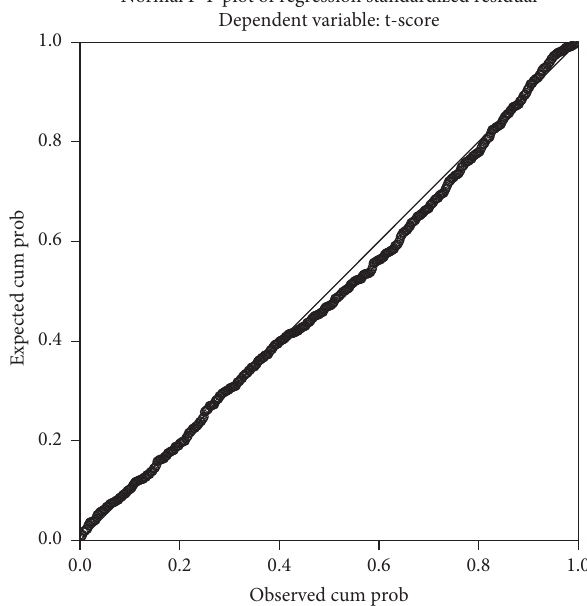
Figure 2: Normal probability plot of regression standardized re- sidual for academic burnout mode. Table 3: Model summary of academic burnout domains on aca- demic achievement. Model Sig.